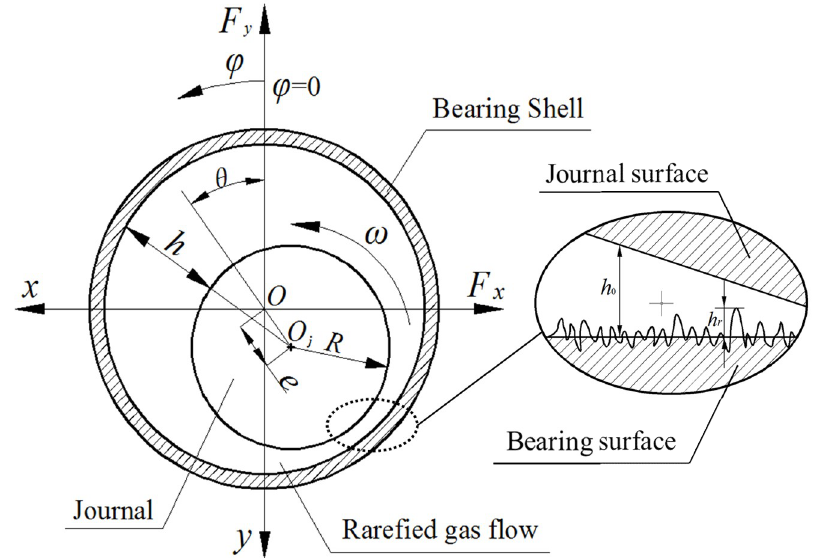
Figure 3. Geometrical configuration of the micro gas-lubricated journal bearing with rough surface.